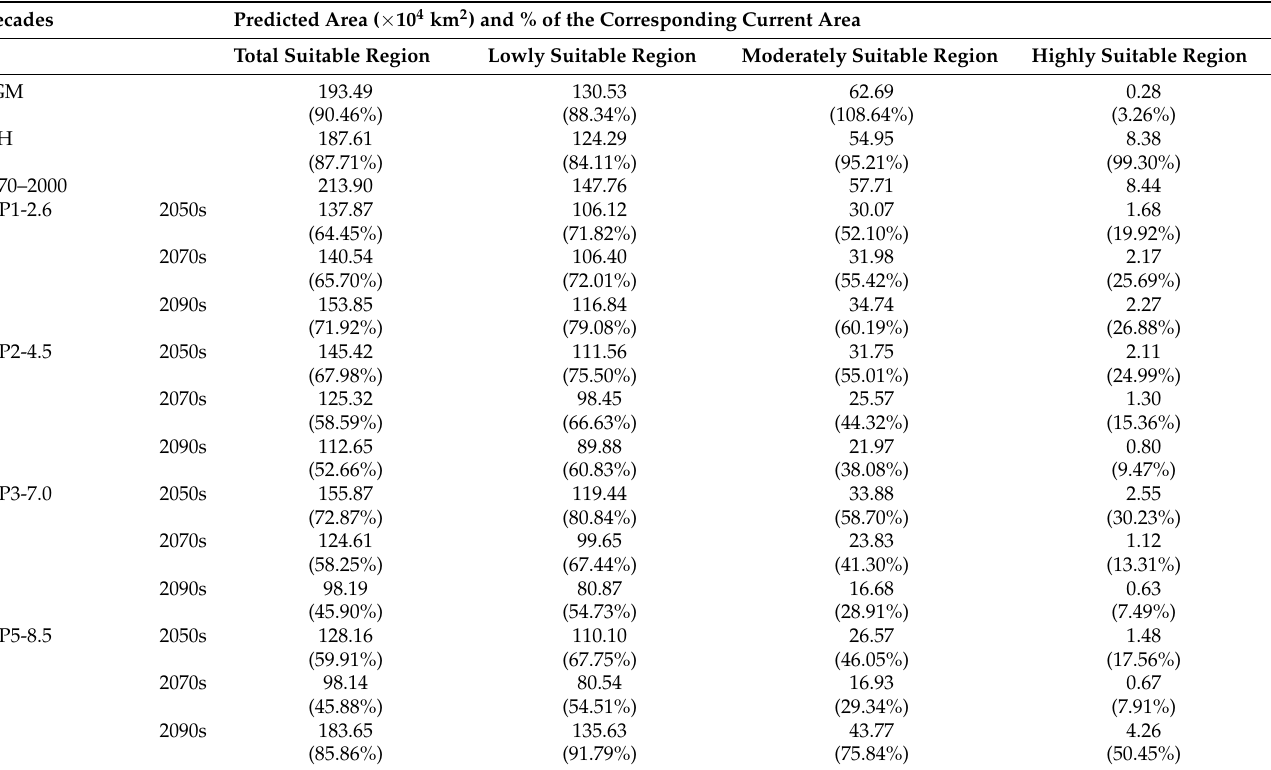
Figure 5. Areas ( a ) and changes ( b ) of habitats of different suitability for C. appendiculata in China during various periods. Table 2. Predicted suitable areas under current and future climatic